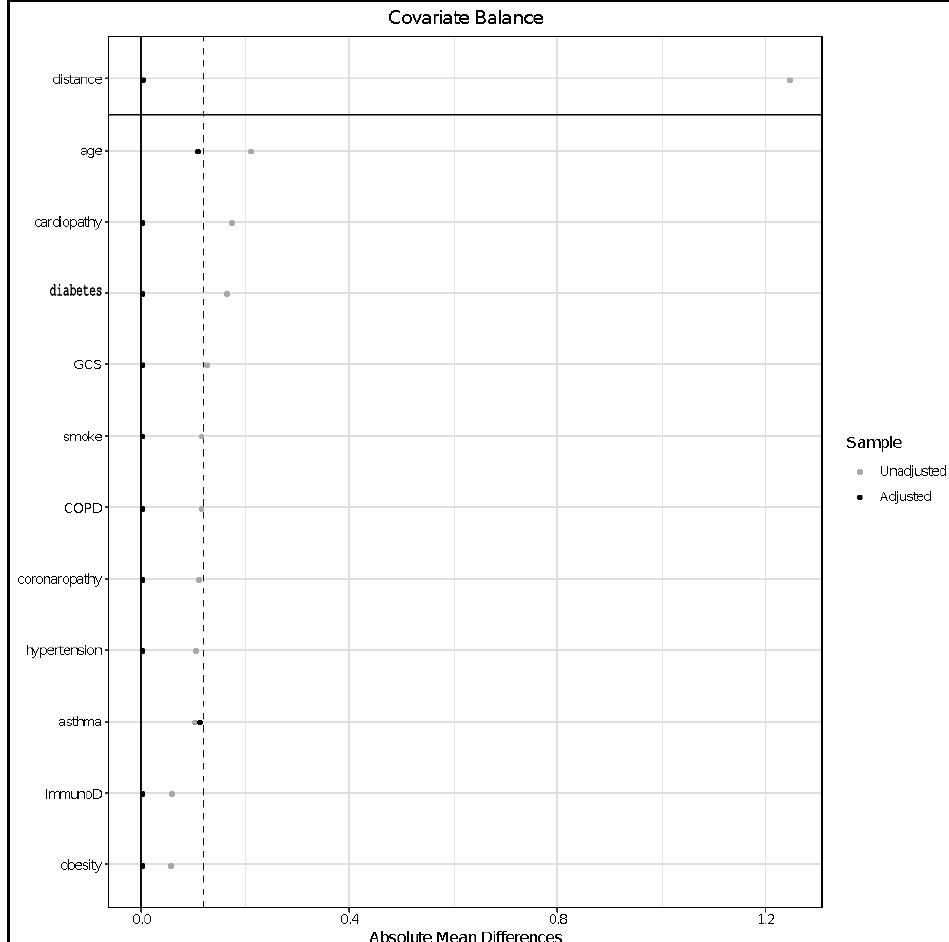
Figure 6. Standardized mean deviation between cases and controls after matching. COPD = chronic obstructive pulmonary disease, GCS = Glasgow coma scale, SBP = systolic blood pressure, ImmunoD = immunosuppression, smoke = active smoking.